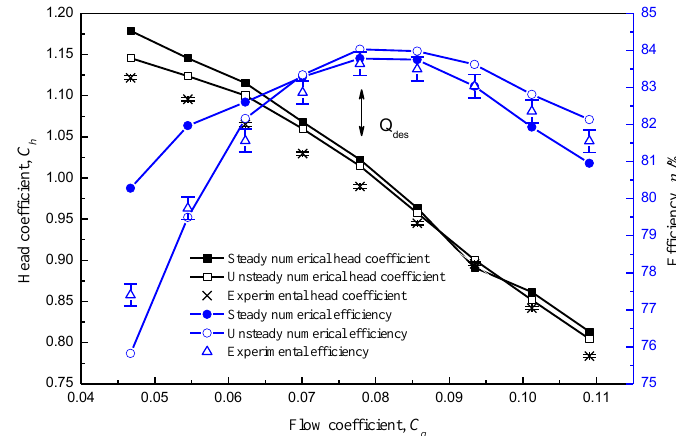
Figure 11. Comparisons of the performance curves.